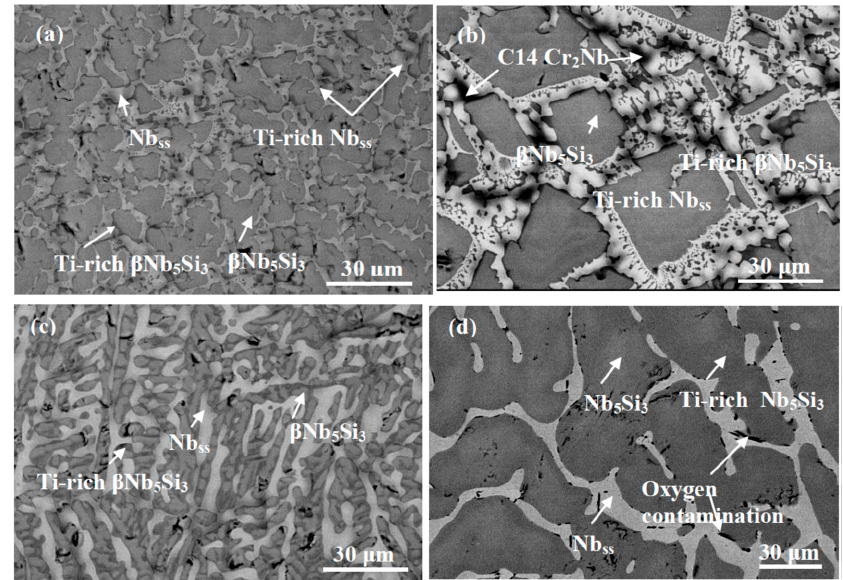
Figure 2. Typical backscatter electron images of the cross section of alloy ZF6: ( a – c ) top, bulk and bottom areas of the as cast alloy ZF6-AC; ( d ) the bulk of the heat-treated alloy ZF6-HT (1400 °C/100 h).